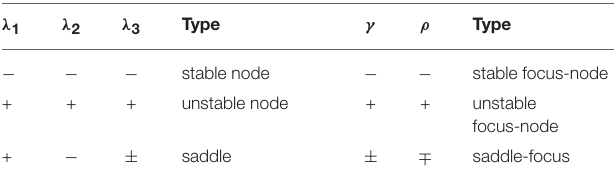
TABLE 1 | Behavior of 3D-systems near hyperbolic equilibrium points with Jacobi matrix having either three real eigenvalues λ i or two complex